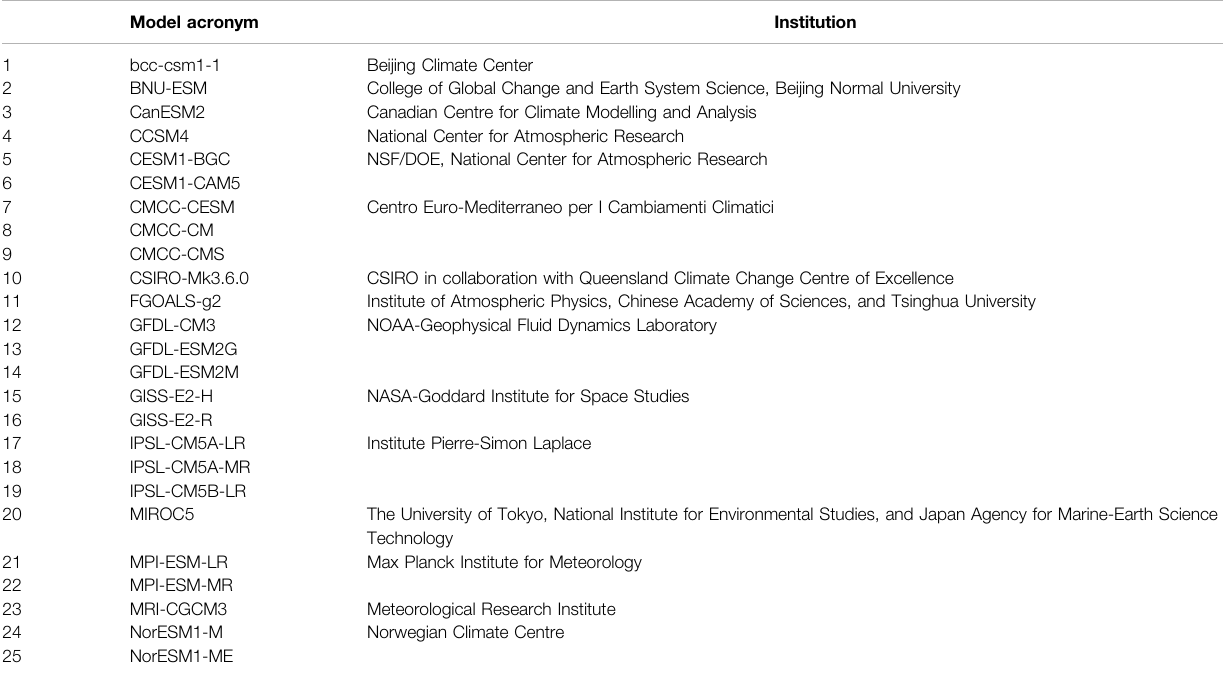
TABLE 1 | A list of the CMIP5 models analyzed in this study. Model